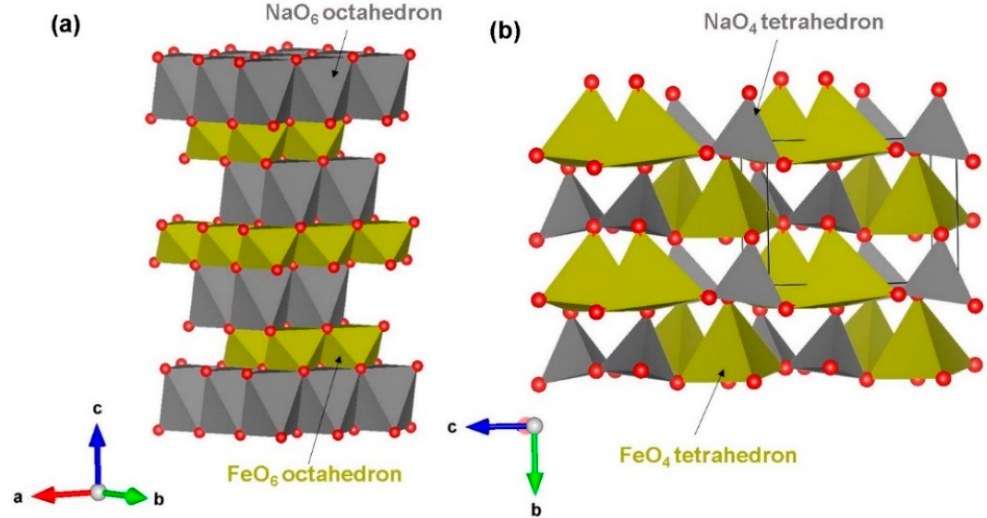
Figure 1. Crystal structures of NaFeO 2 polymorphs: ( a ) hexagonal (space group ( R 3m) and ( b ) orthorhombic (space group Pn2 1 a).